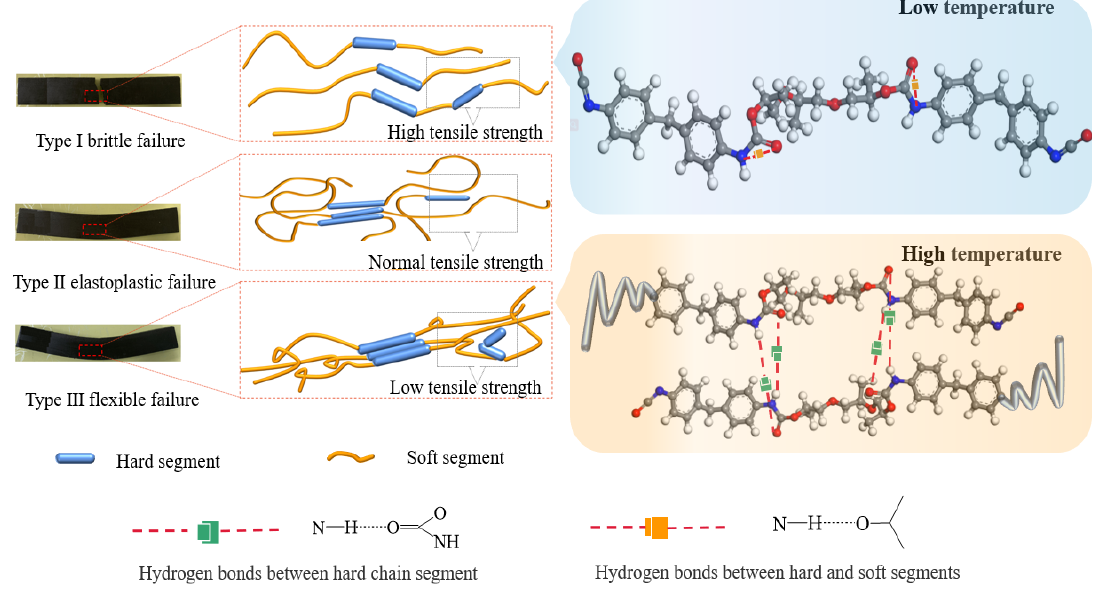
Figure 26. Internal polyurethane stress model under three failure modes.